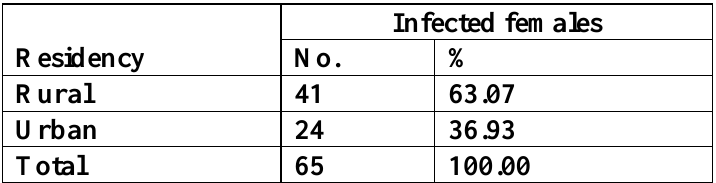
Table (7): Relation between Residency and Trichomoniasis disease.